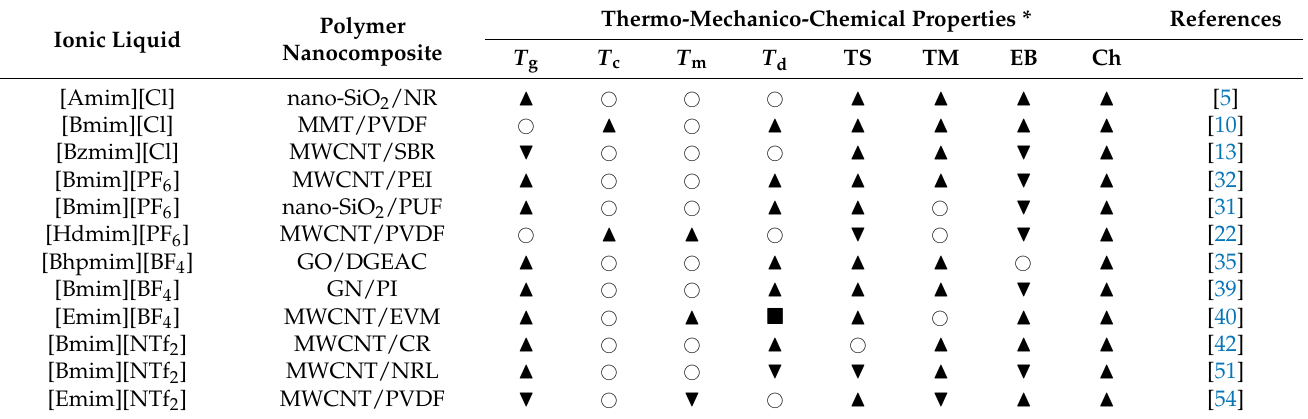
Table 5. Thermo-mechanico-chemical properties of imidazolium-based ionic liquid-modified nanofiller/polymer nanocomposites. Polymer Ionic Liquid